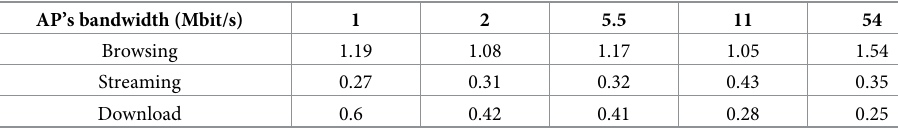
Table 3. Normalized standard deviation of each application